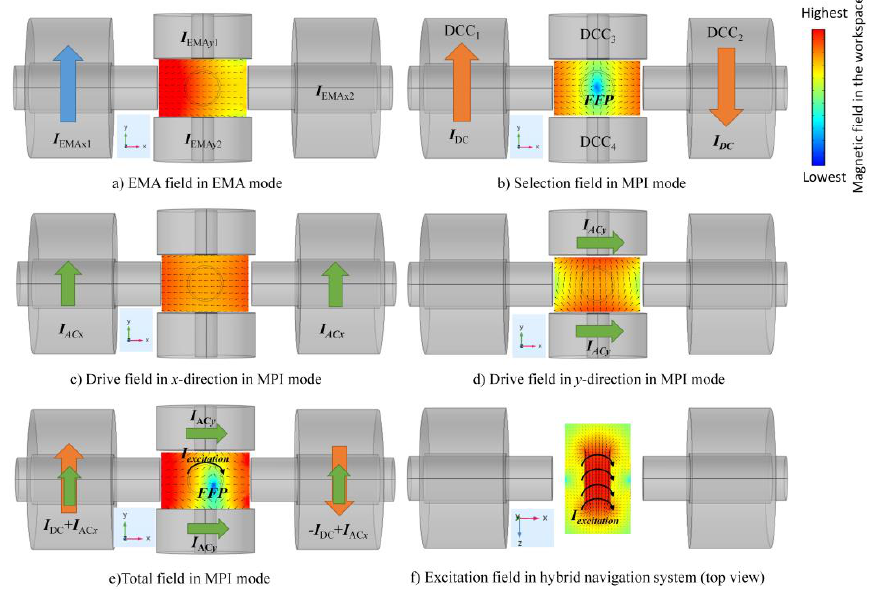
Figure 1. The functional magnetic fields generated by different currents in the workspace. The color and length of the cones represent the magnitude field strength, while the direction of the cones denotes the field direction. ( a ) During the electromagnetic actuator (EMA) period, the EMA field, which is a gradient field used to steer the magnetic nanoparticles (MNPs) to the left-side of workspace, is induced by current I EMAx1 in differential-current coil 1 (DCC 1 ). ( b ) A field-free point (FFP) is located at the center of the selection field, which is generated by Maxwell coil pair (Both coils in Maxwell coil pair are applied with the same I DC current but different coil direction. ( c , d ) The drive fields in magnetic particle imaging (MPI) mode are generated by time-varying drive fields with I ACx and I ACy currents and f x and f y frequencies in the x - and y -axes coils, respectively. ( e ) Total field results in MPI mode. Movement of the FFP depends mainly on the selection field and the drive fields ( I DC and I AC are applied simultaneously), and the FFP moves in the x - y plane. To oscillate the magnetization of the particles, an excitation field is generated by the excitation coil with a high-frequency and low-amplitude I excitation current. The amplitude of the excitation field is small enough to ignore FFP movement in the z -axis. The excitation field is homogeneous, as shown in ( f ).